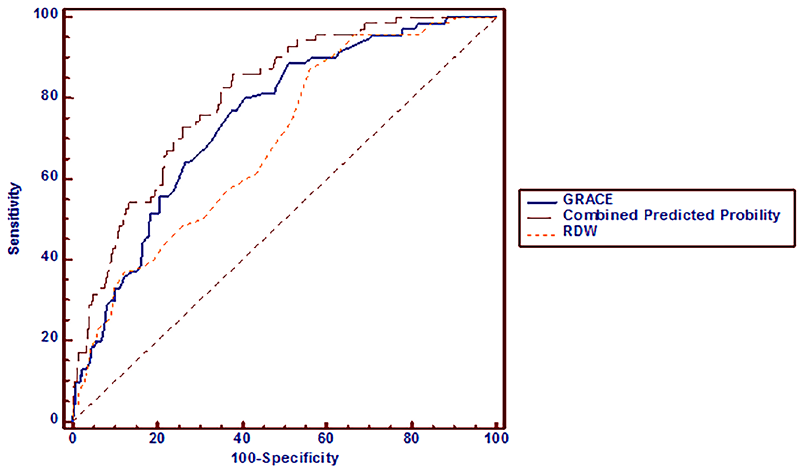
Fig 2. Receiver operating characteristic (ROC) curve analysis for predicting cardiovascular events. For GRACE score alone, the area under the curve (AUC) was 0.749 (95% CI: 0.707 – 0.787). When RDW was added to GRACE score, the AUC was 0.805 (95% CI: 0.766 – 0.839, p =